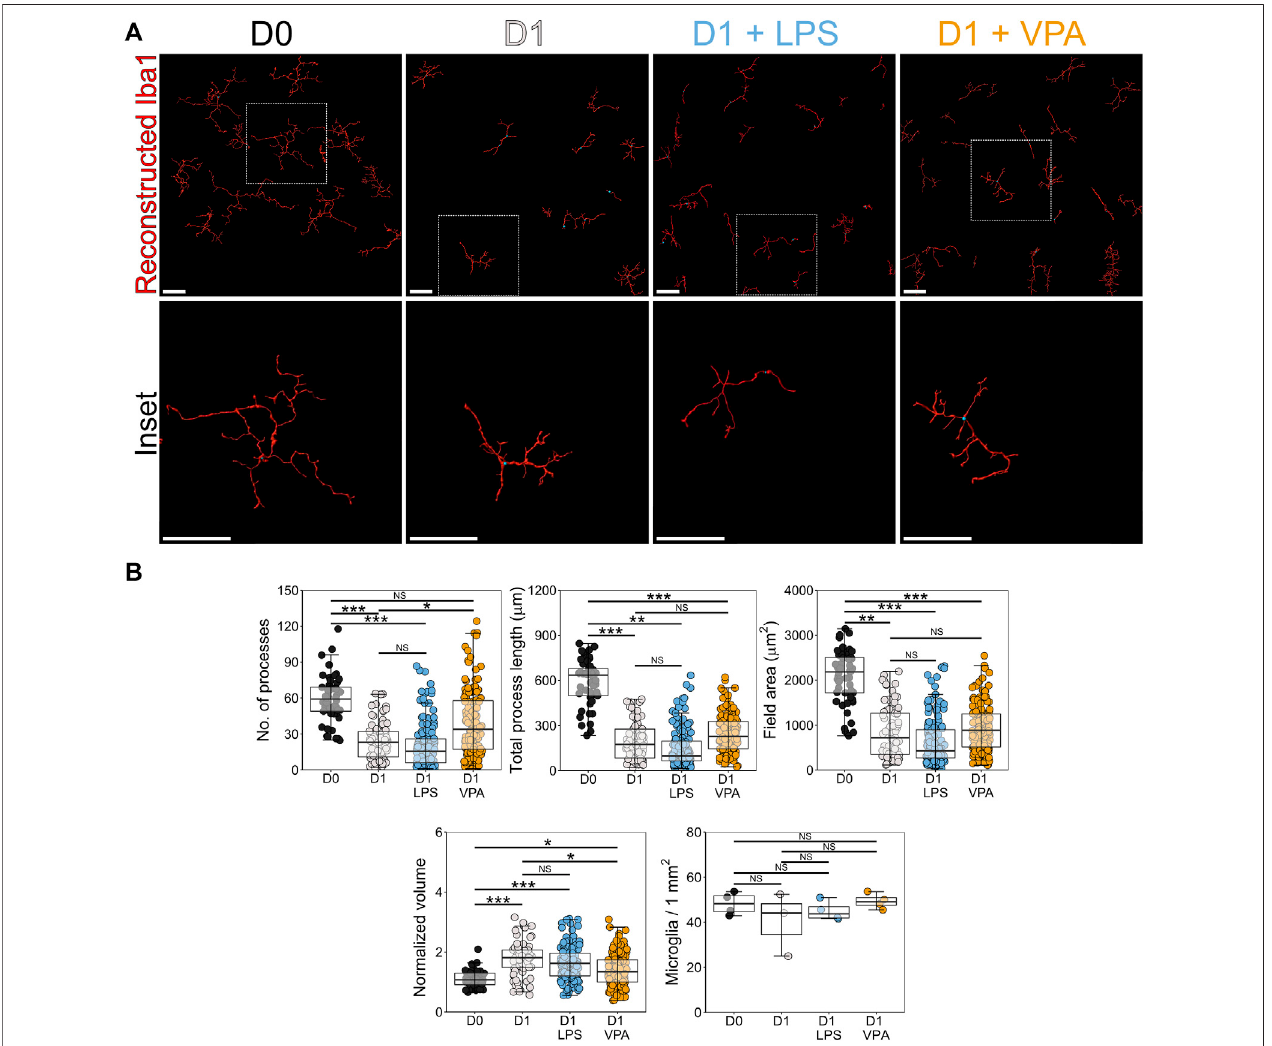
FIGURE 2 | Valproic acid reduces microglial morphological changes associated with pro-in fl ammatory phenotypes. (A) Retinal explants were exposed to LPS, VPA, or untreated and assessed at D1 in comparison to D0 controls. Individual IBA1 labeled microglia were reconstructed using Imaris software. (B) At D1 there was a signi fi cant reduction in the number of microglia processes, total process length, fi eld area, and normalized volume, demonstrating that microglia became less complex and more voluminous, as occurs with a shift towards pro-in fl ammatory phenotypes. LPS treatment did not signi fi cantly enhance this morphological change. Addition of VPA signi fi cantly attenuated these morphological changes, as the number of processes remained higher, and volume was lower than in D1 controls. Total process length and fi eld areawere unchanged. There were nosigni fi cantchangesin microglial numbers inretinas exposed toVPA or LPS. Thesesuggest areduction in the magnitude of a pro-in fl ammatory shift and a retention of some morphological aspects associated with microglial support functions. n = 4 retinas for all conditions, scale bars = 50 μ m, * = p < 0.05, ** = p < 0.01, *** = p < 0.001, NS = non-signi fi cant.